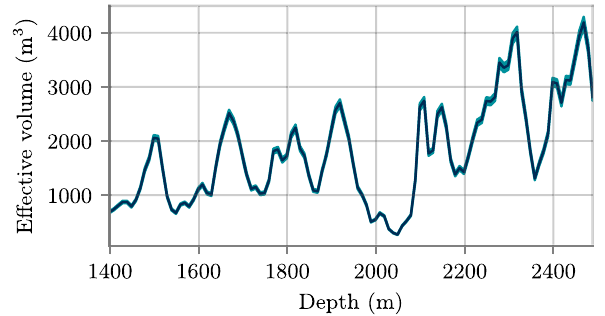
Fig. 4 Effective detection volume of an mDOM for electrons with an energy of 25MeV as a function of depth